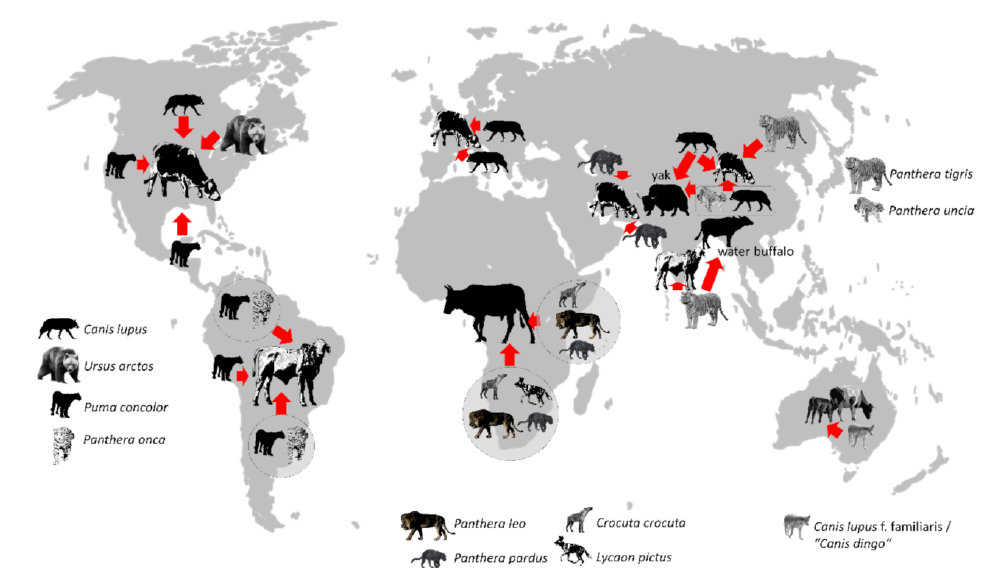
Figure 2. Selected examples of carnivore–cattle conflicts on a global scale—if not further specified, ungulate silhouettes refer to different forms of cattle derived from the aurox Bos primigenius . All animal silhouettes derived from photos: T. Göttert. References: Canis lupus , North America: [75,76]; Ursus arctos : [77]; Puma concolor , western North America: [78]; Puma concolor , central America: